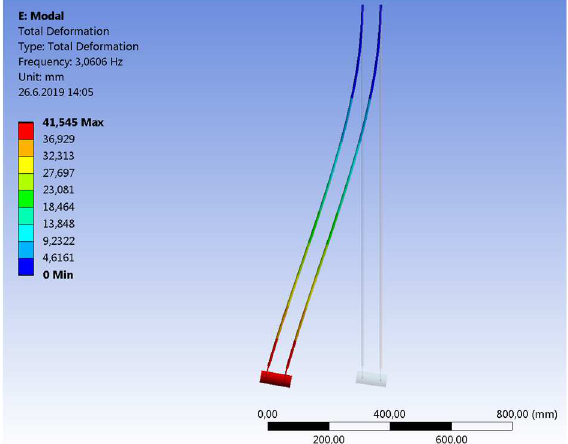
Fig. 13. Maximum deflection from a numerical test for a cyclicali waken